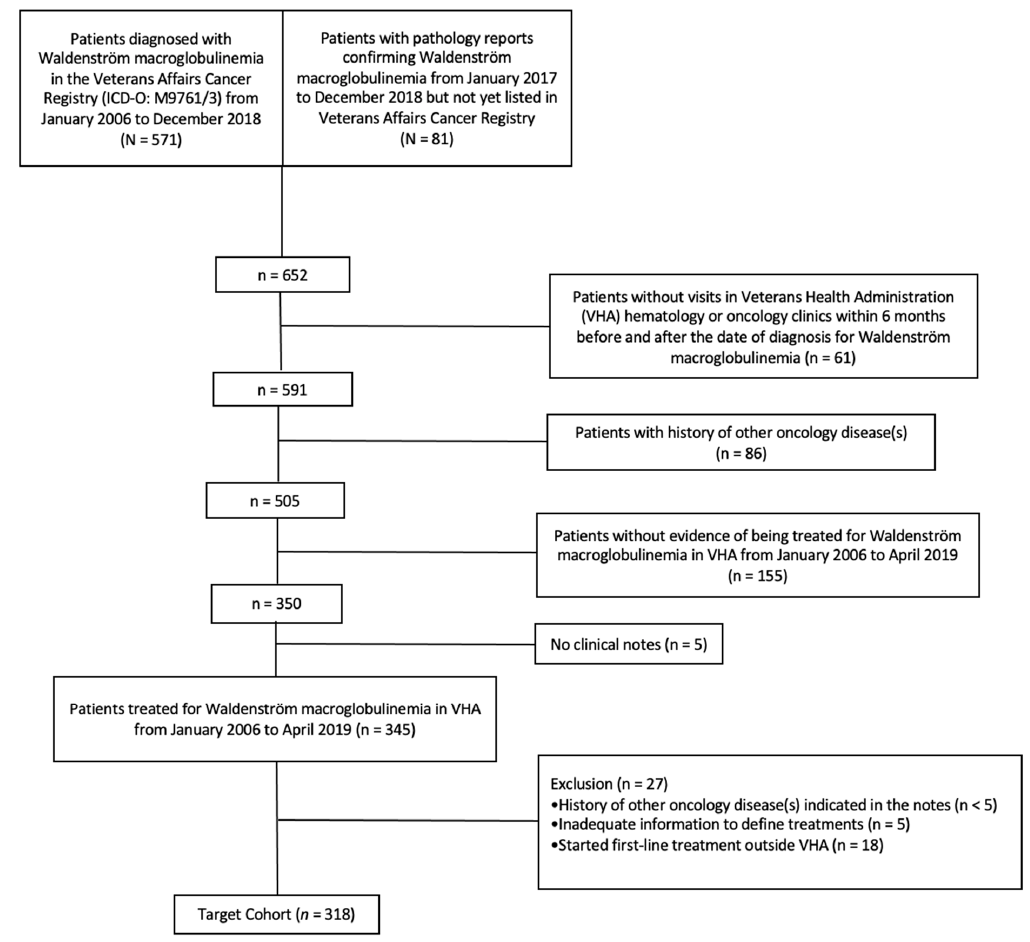
Figure 1. Cohort selection flowchart.